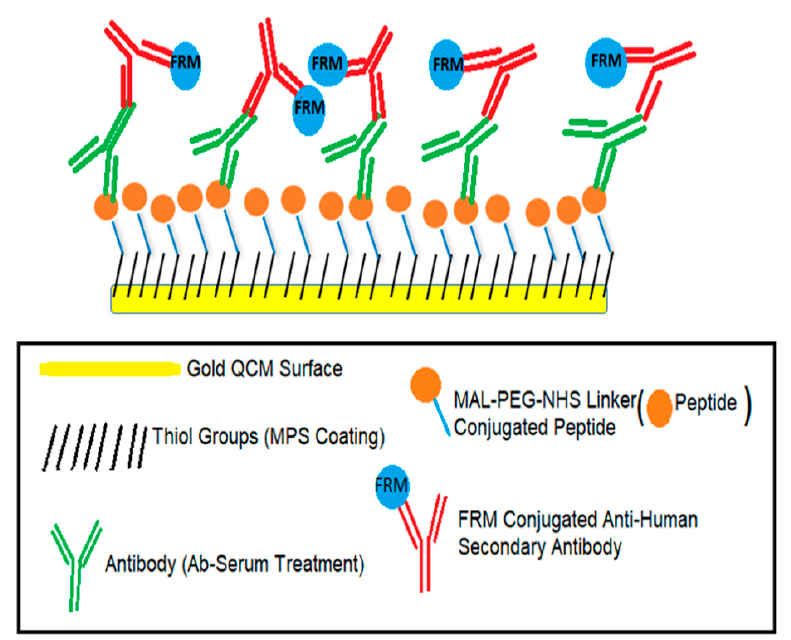
Figure 1. Schematic diagram of the quartz crystal microbalance (QCM) experiment steps. These steps are 3-mercaptopropyltrimethoxysilane (MPS) coating, peptide immobilization, serum treatment (Antibody (Ab) binding) and fluorescent reporter microspheres (FRMs) conjugated anti-human secondary antibody treatment.